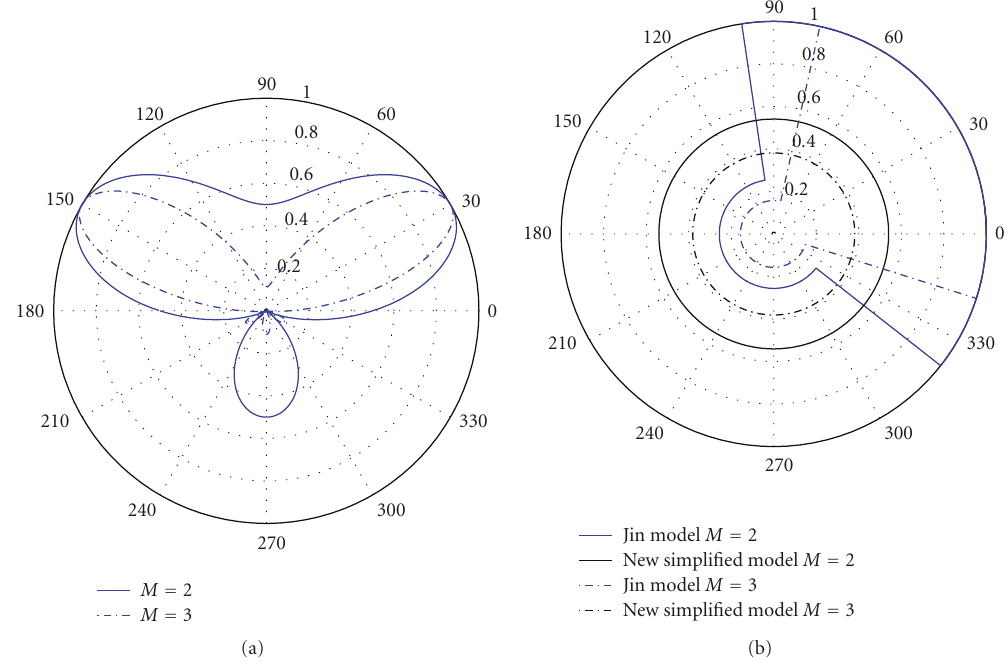
Figure 3: A simplified model for beamforming with arrival angle θ = 30 ◦ . (a) Signal model, (b) interference model.